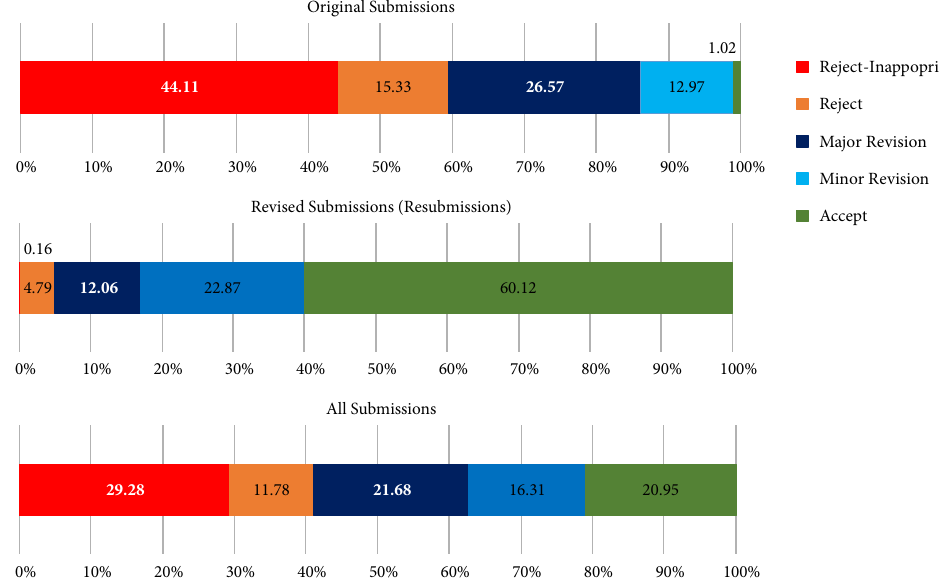
Fig. 1. Decision ratios of the submitted manuscripts in 2011–2017